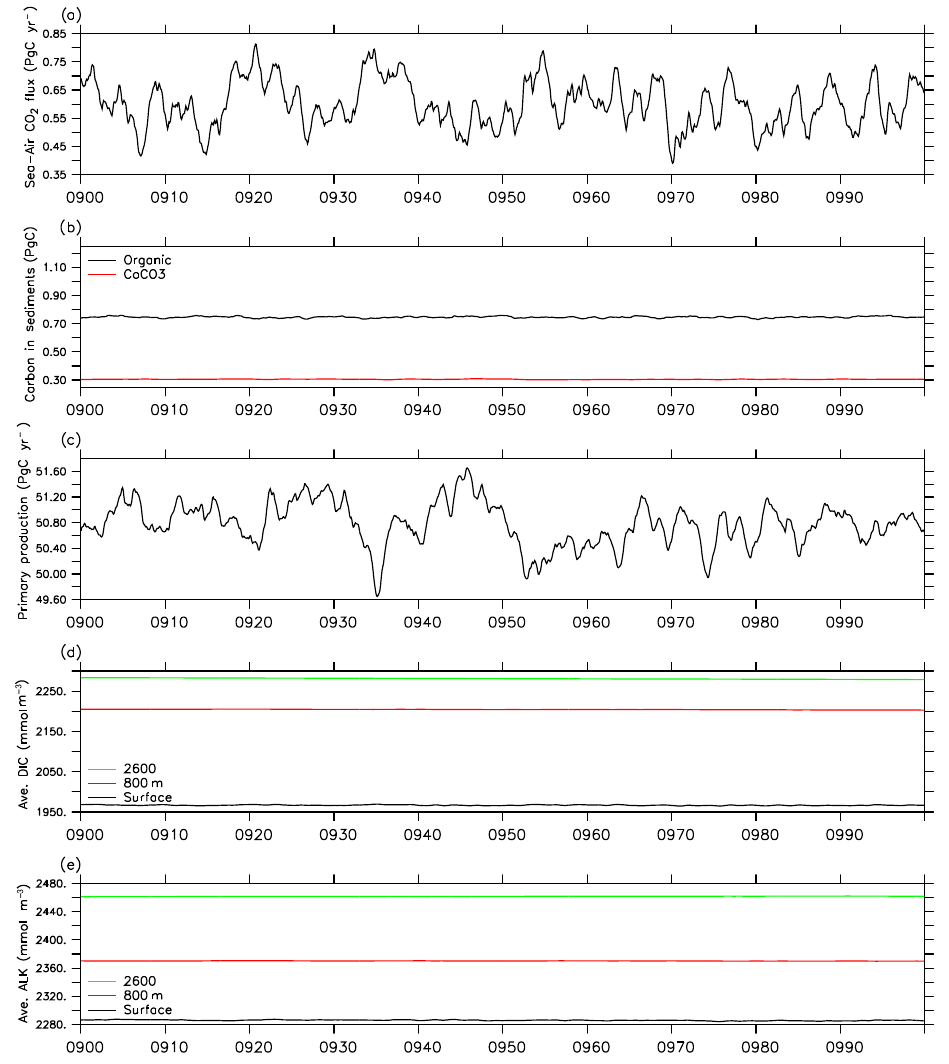
Figure 7. For the ACCESS-ESM1 simulation the global (a) sea–air flux of carbon dioxide in PgCyr − 1 , (b) carbon content of the organic (black) and calcium carbon sediment (red) pools in PgC, (c) net primary productivity in PgCyr − 1 , (d) global-averaged dissolved inorganic carbon in mmolm − 3 at various depths and (e) global average alkalinity in mmolm − 3 at various